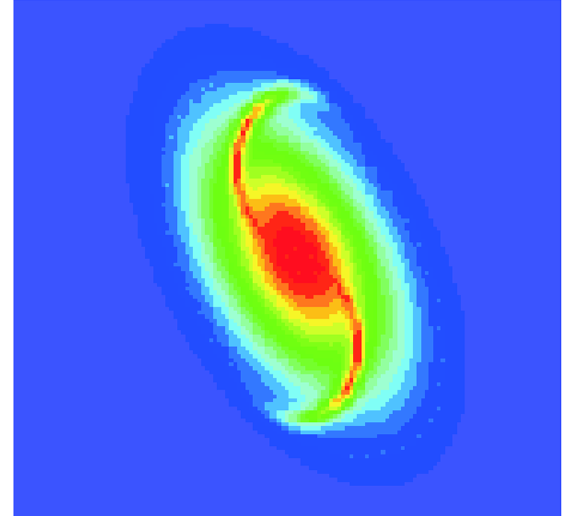
FIG. 1. (Color) The phase-space density distribution of the phantom in the Y - Y 0